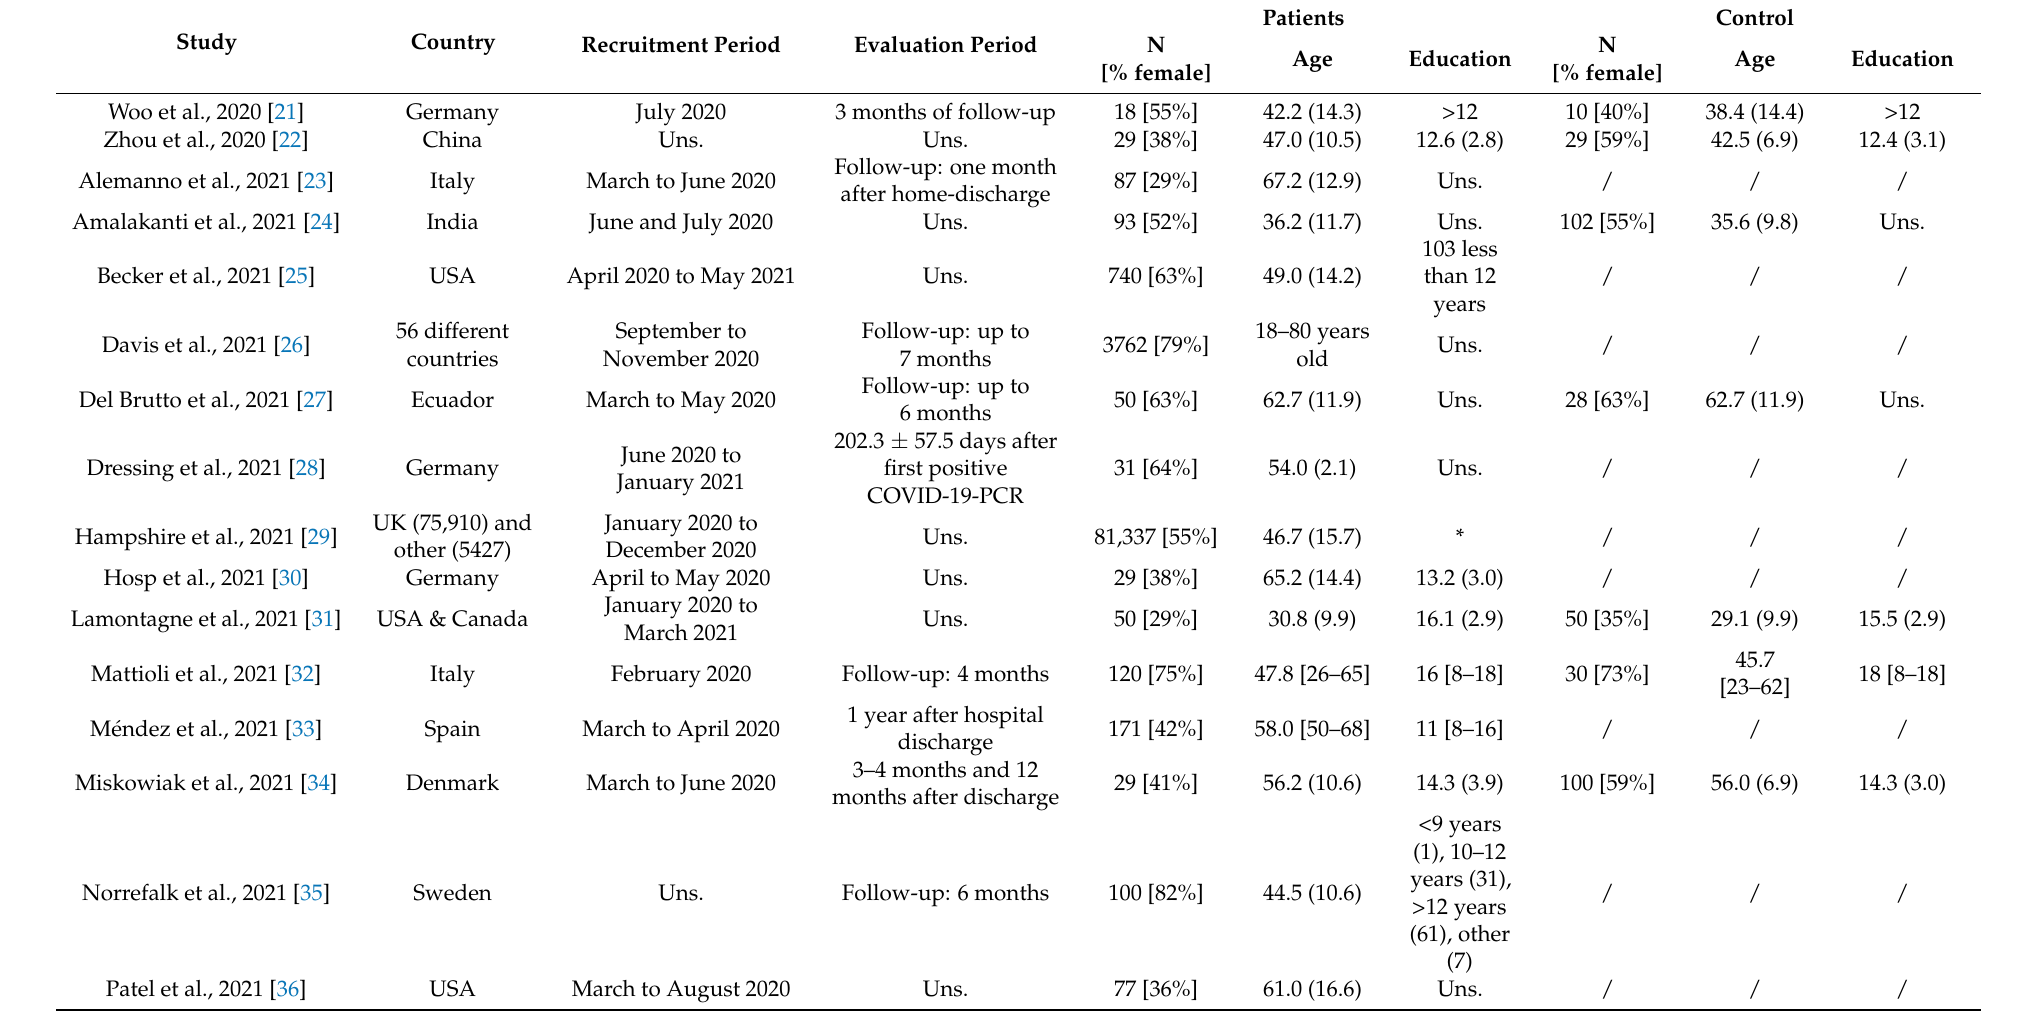
Table 1. Main characteristics of the included studies and socio-demographic characteristics of the patients. Age results are presented as mean (SD) or median [p25–p75] according to the